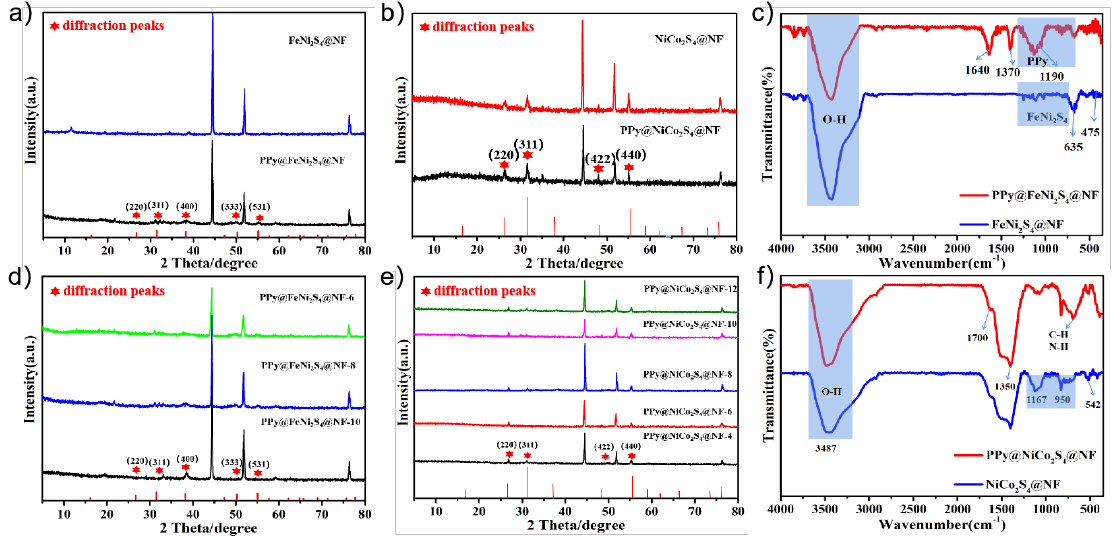
Figure 2. ( a ) XRD patterns of FeNi 2 S 4 @NF and PPy@FeNi 2 S 4 @NF, ( b ) XRD patterns of NiCo 2 S 4 @NF and PPy@NiCo 2 S 4 @NF, ( d , e ) XRD patterns of PPy@FeNi 2 S 4 @NF and PPy@NiCo 2 S 4 @NF at different reaction times, ( c ) FTIR spectra of FeNi 2 S 4 @NF and PPy@FeNi 2 S 4 @NF, and ( f ) FTIR spectra of NiCo 2 S 4 @NF and PPy@NiCo 2 S 4 @NF.